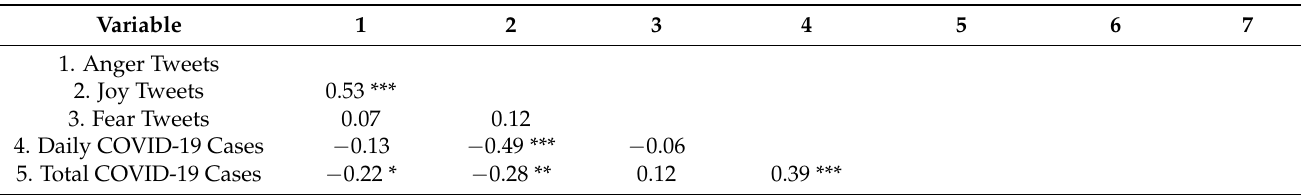
Table A5. Florence Pearson’s correlation coefficient